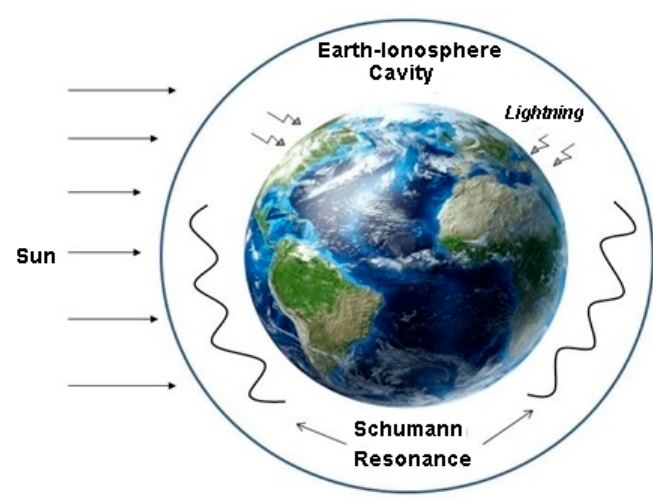
Figure 1. Phenomenon of Schumann Resonance.